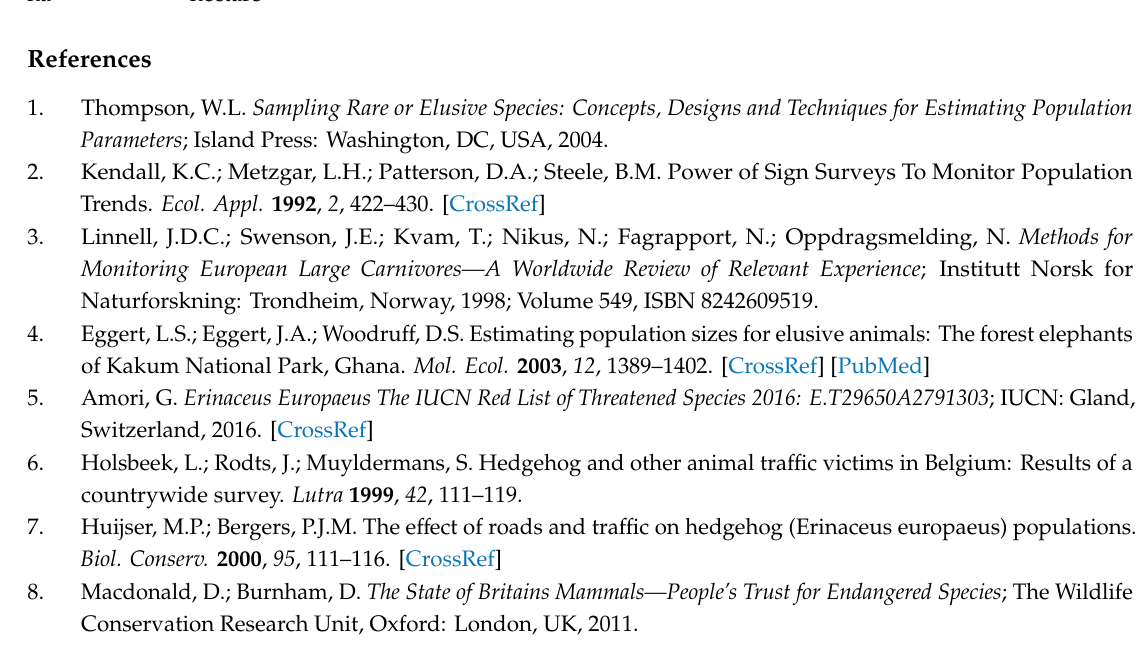
Figure S1: Sequence alignment of ITS-2 sequences showing positions of discriminatory primers resulting in specific PCR products di ff ering in length by 50 bp. Figure S2: PCR of extracted nematode DNA with CS / CV multiplexed primer set illustrating specific